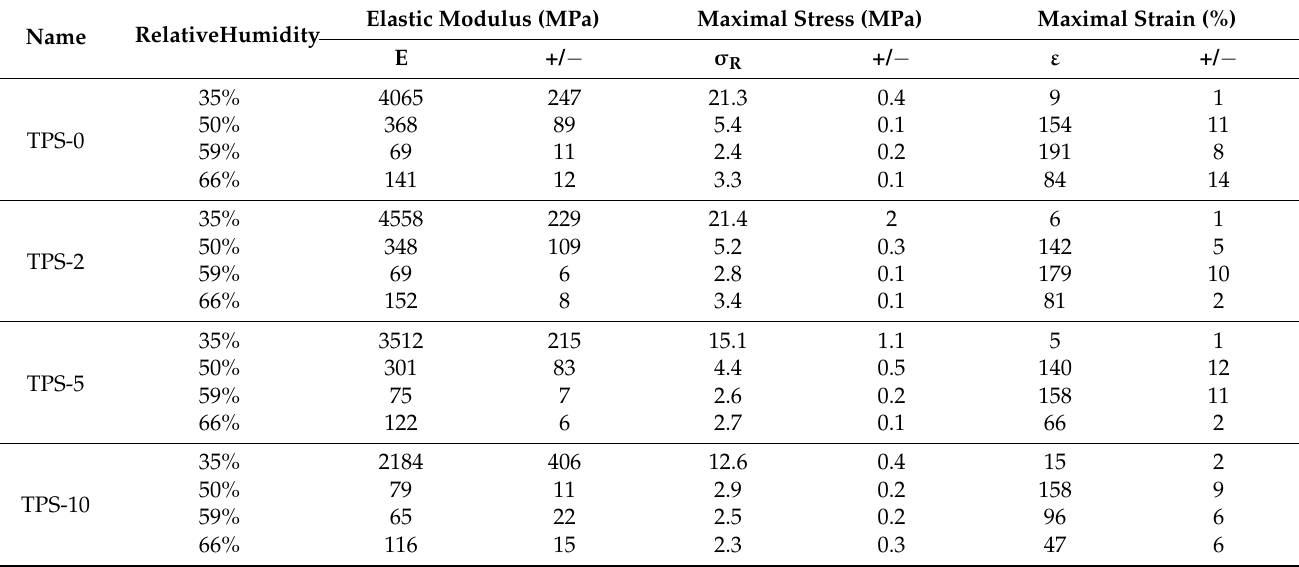
Table 1. Mechanical properties of TPS/FASE blends (Elastic Modulus; Maximum stress; Maximum strain) as a function of the FASE ratio at different relative humidities.